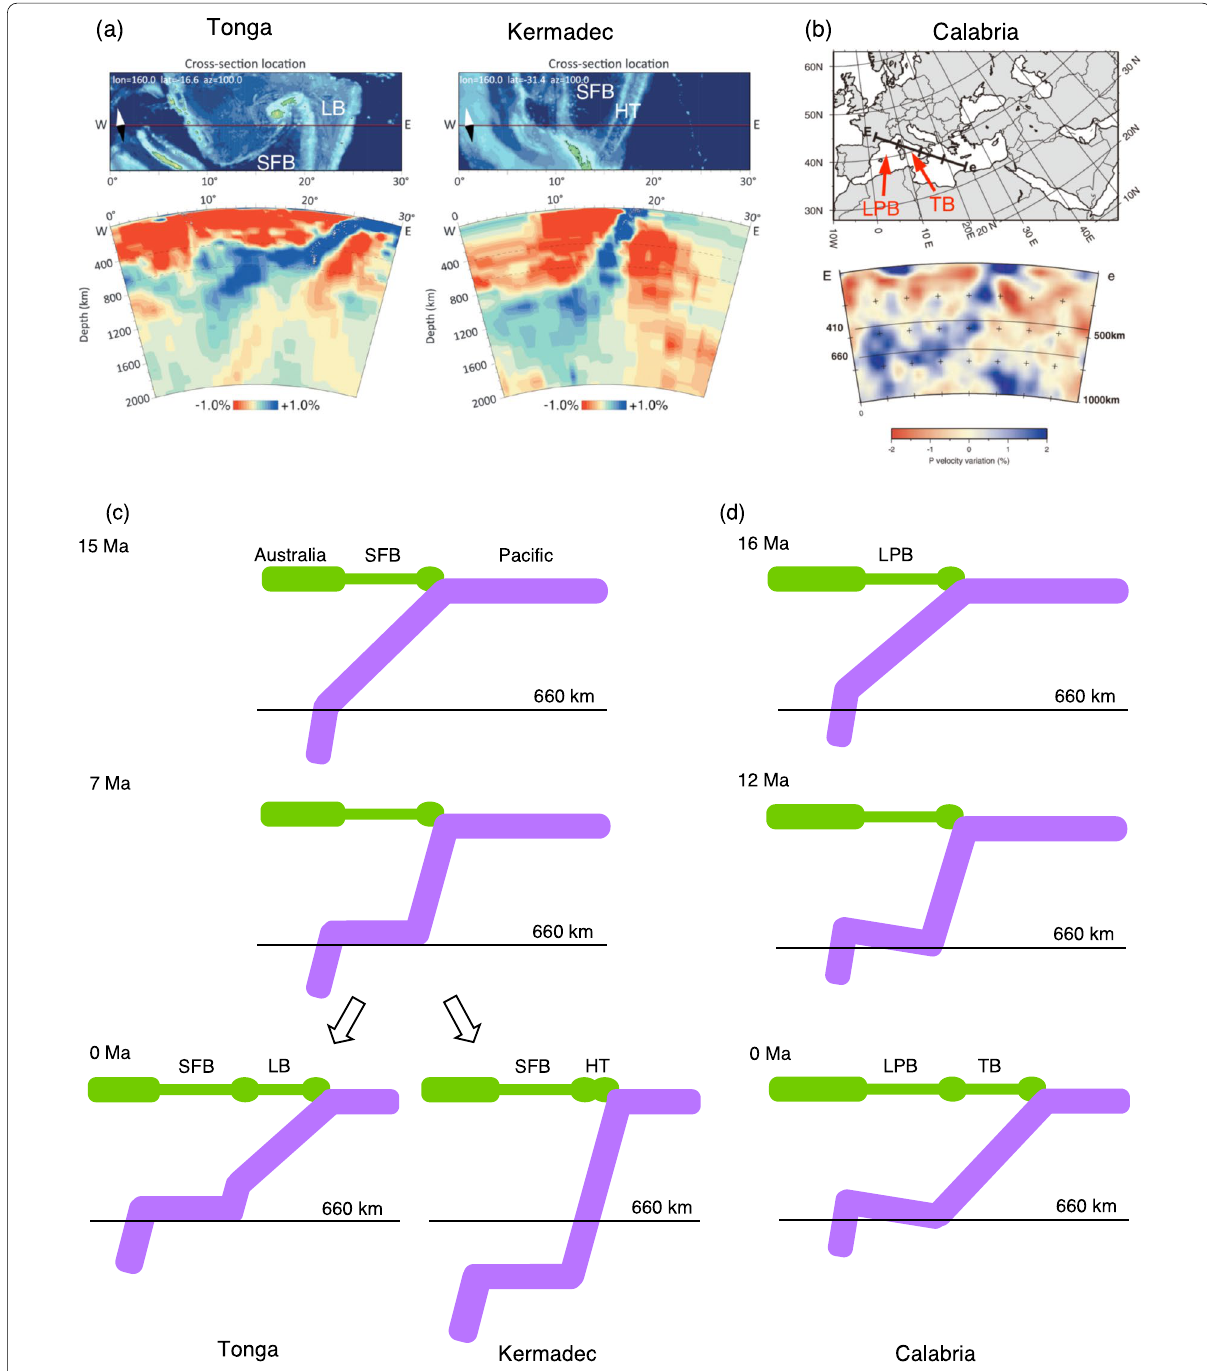
Fig. 8 a Seismic tomography image of the Tonga-Kermadec arc (van de Lagemaat et al. 2018). b Seismic tomography image of the Calabrian arc (Piromallo and Morelli 2003). c , d Estimated evolution of slab geometry beneath the Tonga-Kermadec arc ( c ) and the Calabrian arc ( d ). SFB South Fiji Basin, LB The Law Basin, HT The Havre Trough, LPB The Liguro–Provençal Basin, TB The Tyrrhenian = = = =